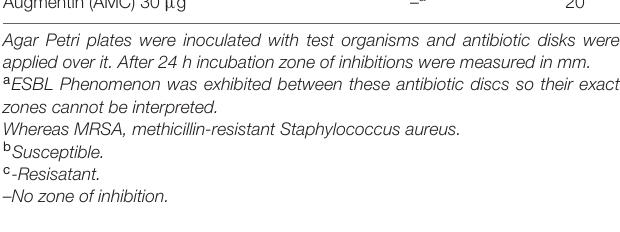
TABLE 2 | Screening of essential oils (EOs) by agar well diffusion